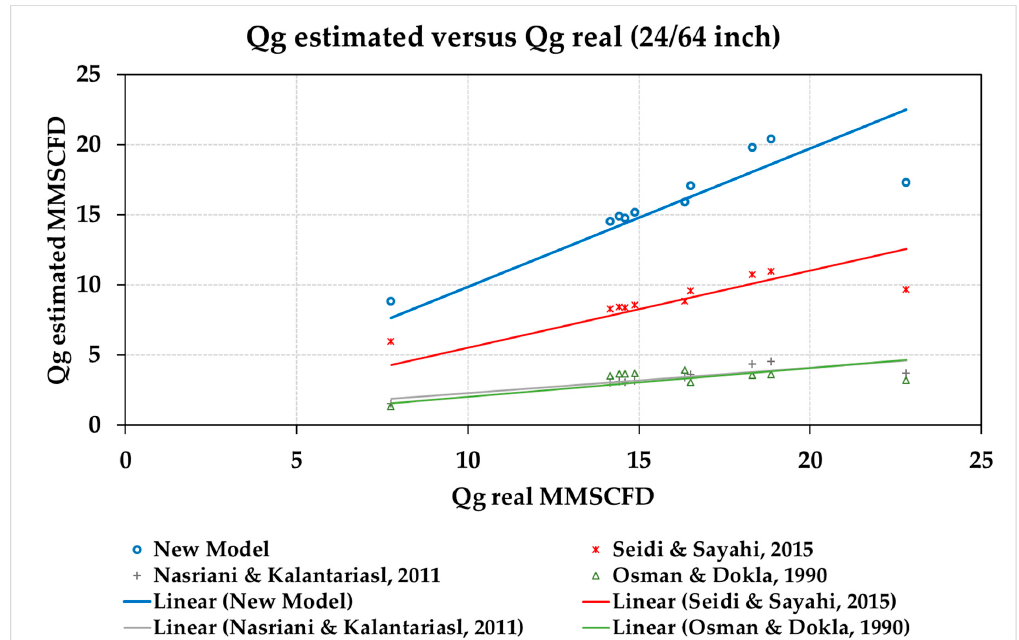
Figure 5 . Estimated gas flow rate versus real gas flow rate (24/64 inch) .